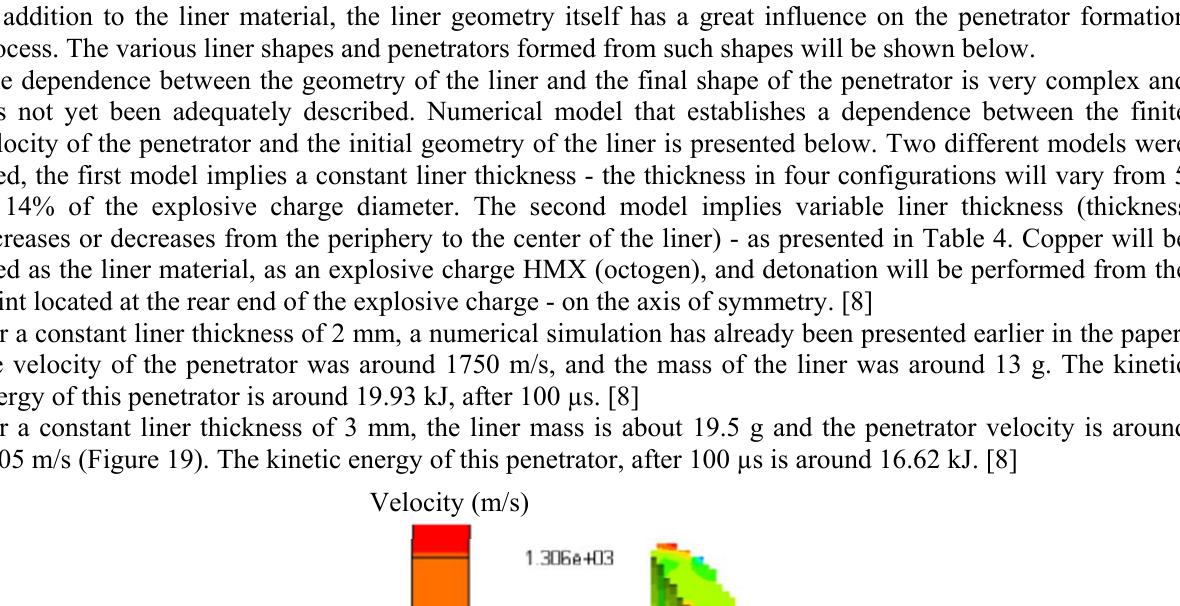
Figure 18. Hollow EF penetrator (left); Solid EF penetrator (right) [9]